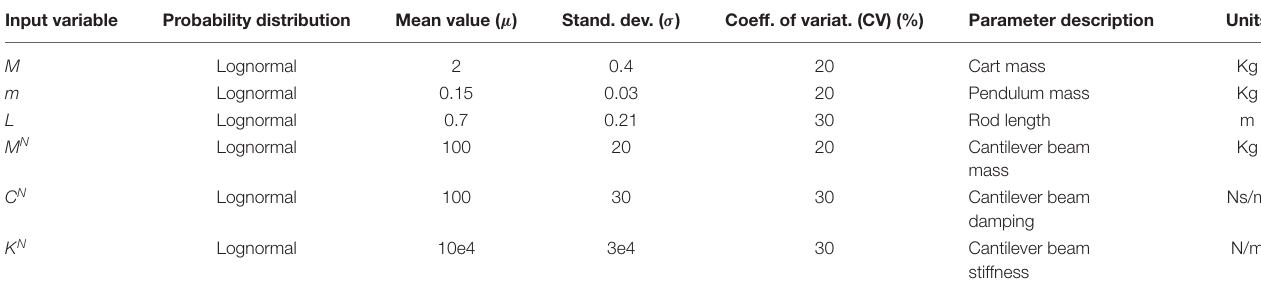
TABLE 1 | CS1: Variation of the random parameters in the hybrid model. Input variable